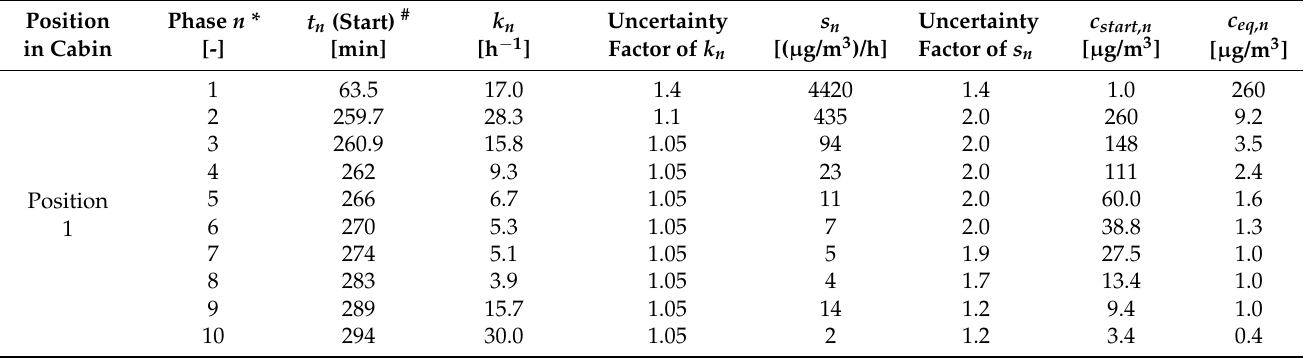
Figure 4. Results of the particle measurement and fitting process at position 1 close to the aerosol release and the changed parameters like source on/off, start of pressure rise, and change of air cleaning technique and: ( a ) PM 2.5 and corresponding fitting curve; ( b ) parameters k n and s n of the fitting curve. Table 5. Fitting parameters k n and s n for the fitting curve for position 1 and derived concentration c start,n at the beginning of phase n and equilibrium concentration c eq,n